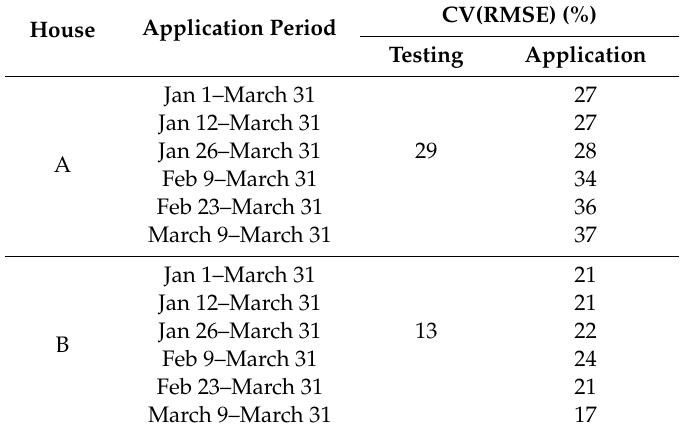
Table 4. CV(RMSE) values over the testing and application periods with the static window technique. House Application Period